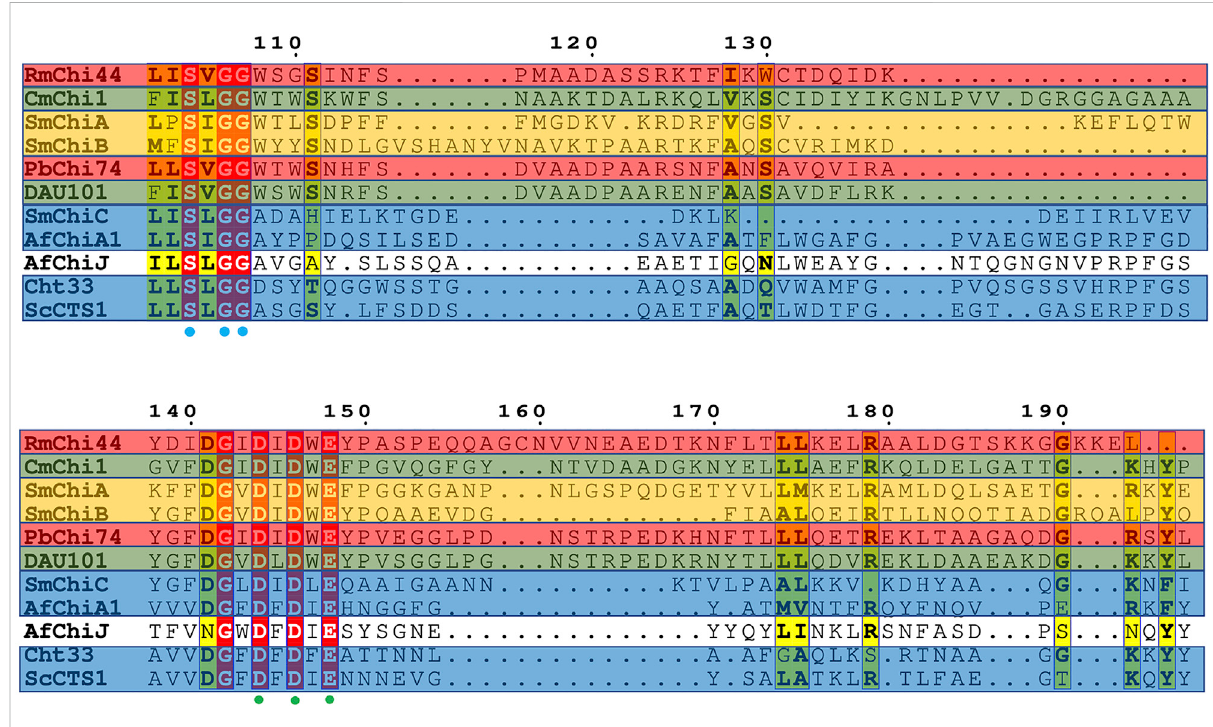
FIGURE 10 Alignment of amine acid sequence homology. Structure-based sequence alignment of 11 homology proteins. Residue numbers are given shadedbysequencesimilaritybetweenthe11enzymesshown(red=identical,yellow=chemicallysimilarresidues).ResiduesDXDXEarehighlighted by green fi lled circles. Residues SXGG are highlighted by blue fi lled circles. Endochitinases are shown in blue background, exochitinases are shown against a yellow background, exo and β -N-acetylglucosaminidases are shown against a red background, endo/exo and β -N- acetylglucosaminidases are shown against a green background.